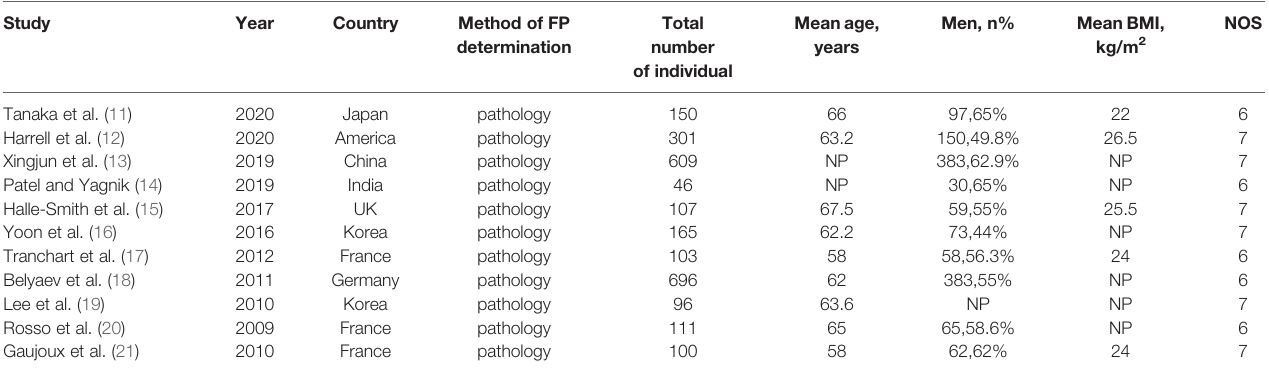
TABLE 1 | Characteristics of included